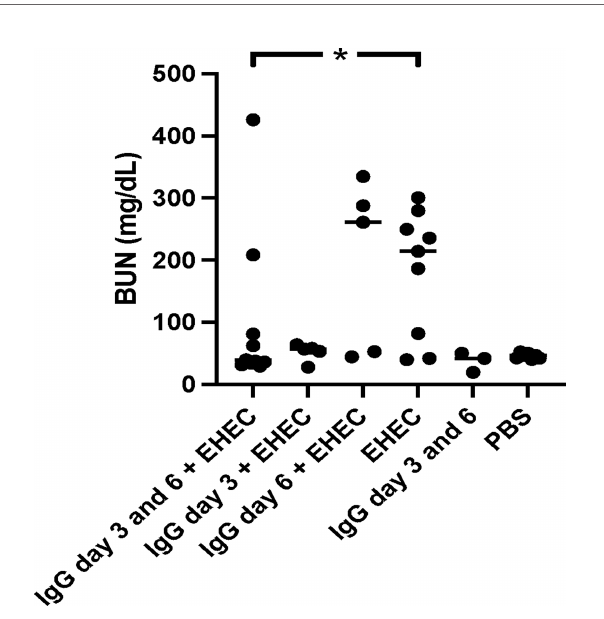
FIGURE 2 | Histopathology in E. coli O157:H7-infected mice. Pathological changes were found in untreated E. coli O157:H7-infected mice. (A) Intestinal in fl ammatory in fi ltrates (white arrow) and mucus-depleted goblet cells (white arrowhead) in a mouse sacri fi ced on day 10 after inoculation in the infected and untreated group (corresponding to pathological score 2 for in fl ammatory in fi ltrates and pathological score 3 for mucus-depleted goblet cells). (B) Renal tubular desquamation (black arrow) in a mouse sacri fi ced on day 10 after inoculation in the infected and untreated group (corresponding to pathological score 3). (C) Normal intestinal histology in infected and IgG treated mouse on day 3 sacri fi ced on day 14 (corresponding to pathological score 0). (D) Normal renal histology in infected and IgG treated mouse on day 3 and 6 sacri fi ced on day 14 (corresponding to pathological score 0). (E) Normal intestinal histology in a control mouse sacri fi ced on day 14 (corresponding to pathological score 0). (F) Normal renal histology in a control mouse sacri fi ced on day 14 (corresponding to pathological score 0). Scale bar 100 m